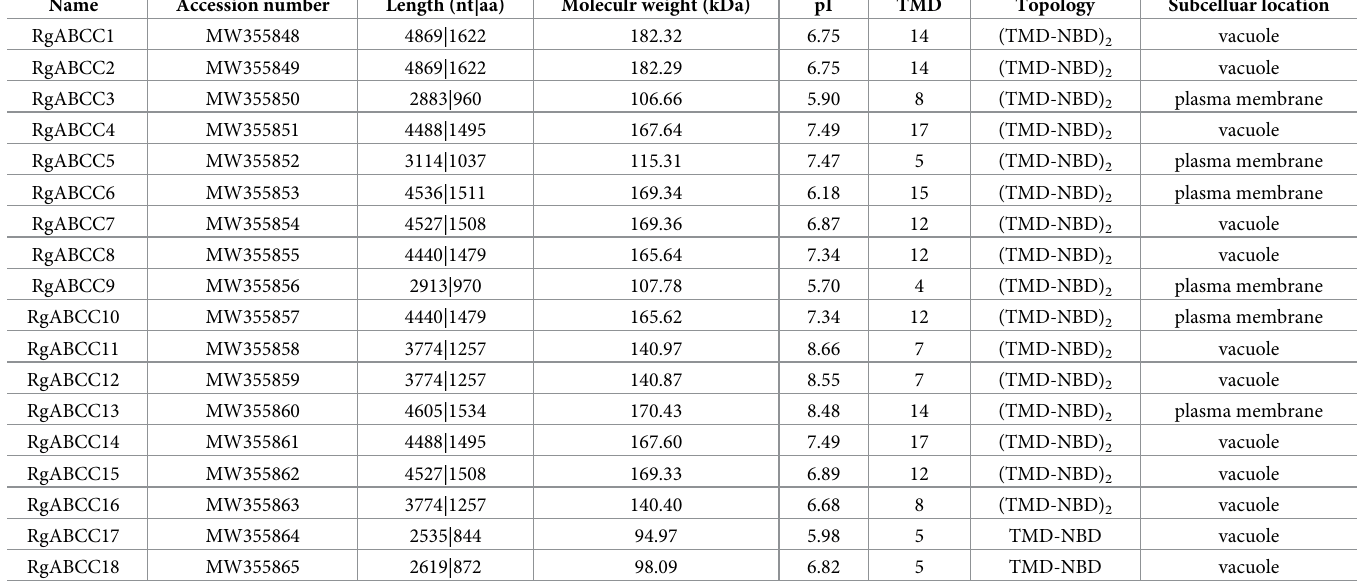
Table 1. Basic information about the RgABCCs in R . glutinosa